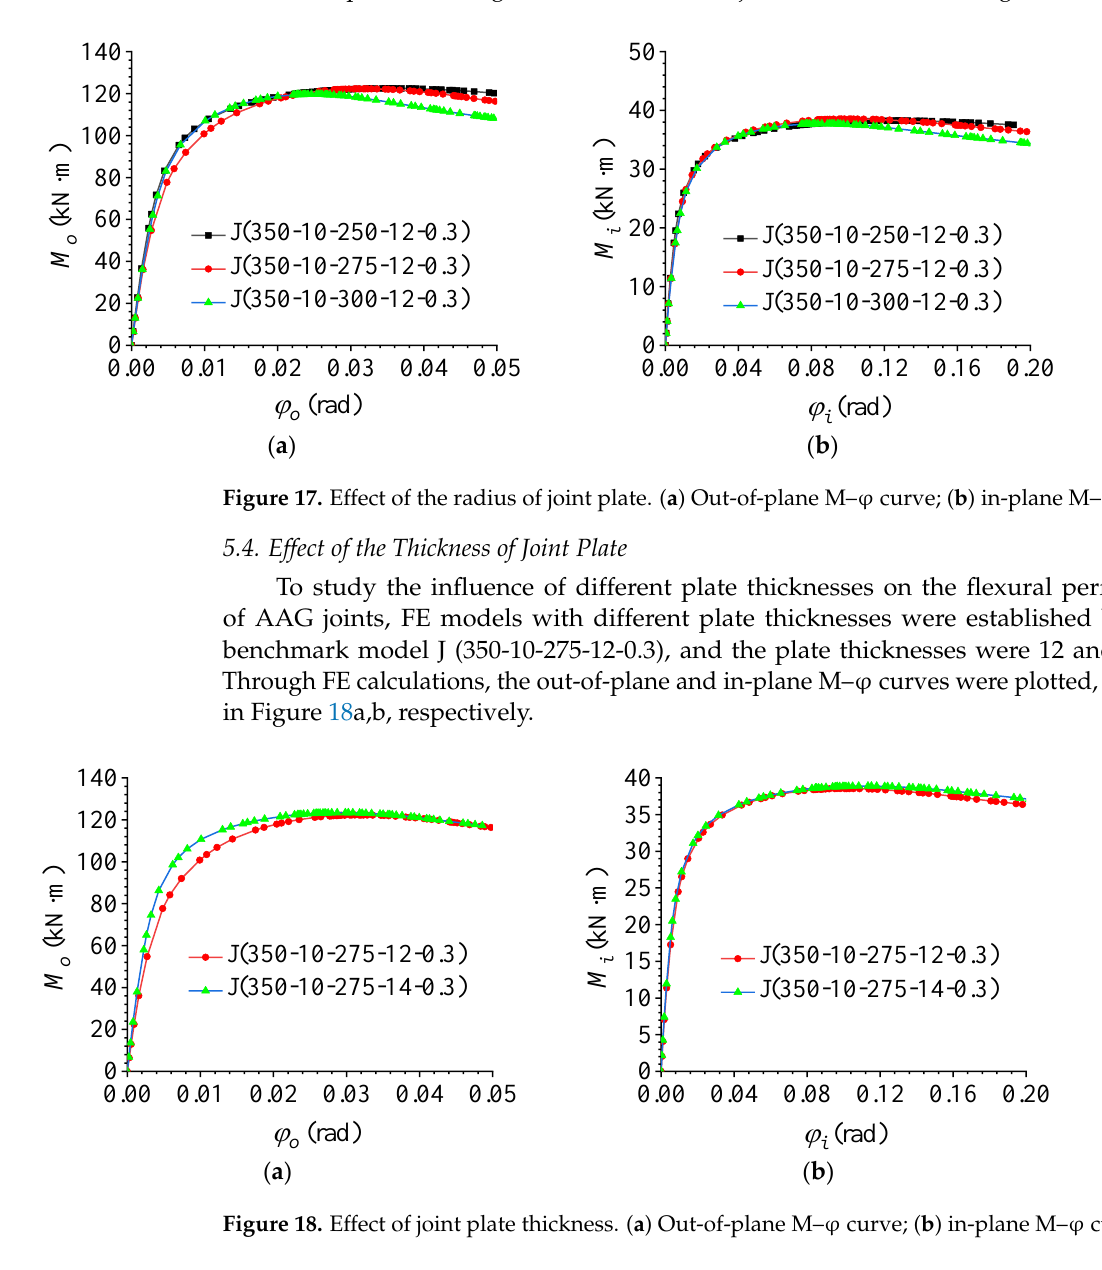
( b ) Figure 19. Effect of the bolt pretension force. ( a ) Out-of-plane M–φ curve; ( b ) in-plane M–φ curve. 5.6. Effect of the Ratio of In-Plane to Out-of-Plane Bending Moments To study the effect of in the ratio between the in-plane and out-of-plane bending mo- ments on the flexural performance of AAG joints, FE models with different ratios between the in-plane and out-of-plane bending moments were established, and the ratios were taken as 0.2, 0.3, 0.4, and 0.5. Through FE calculations, the out-of-plane and in-plane M–φ curves were plotted, as shown in Figure 20a, b, respectively. It can be observed that the change in the ratio between the in-plane and out-of- plane bending moments had a significant influence on the bending behavior of the AAG